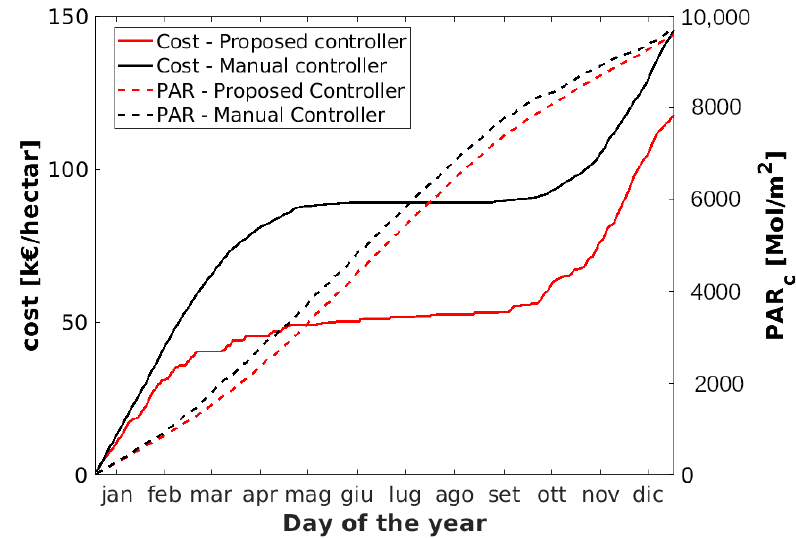
Figure 11. Year-long simulation and evaluation of the satisfaction of control goals. Black lines refer to the existing state-of-the-art controller, while red lines refer to the proposed controller. Dashed lines indicate the cumulative PAR c reaching the crop; Continuous lines indicate cumulative electrical energy